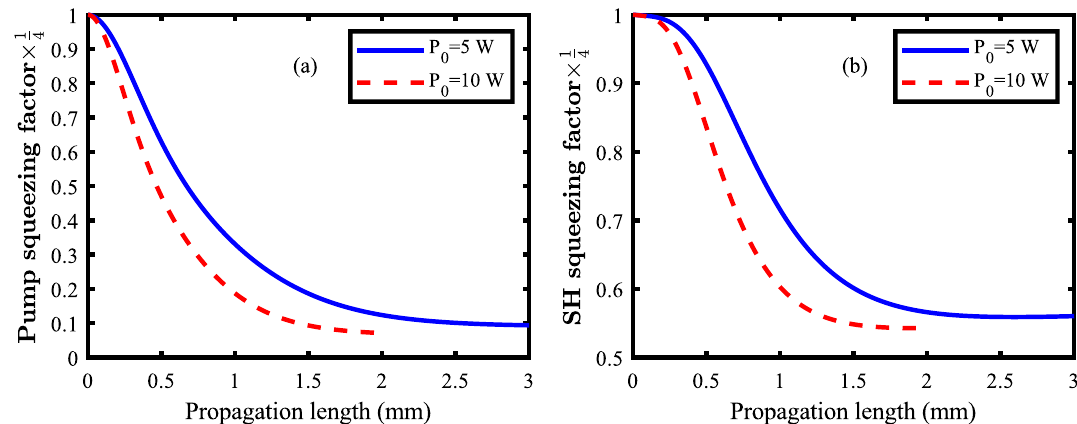
Figure 7. Squeezing of the pump mode ( a ) and the SH mode ( b ) for different values of the initial pump power ( P 0 = 5 W and 10 W